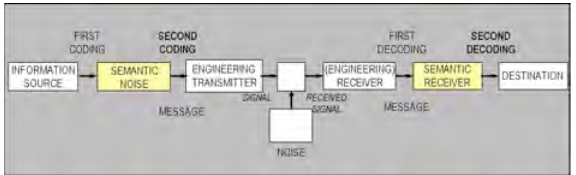
Fig. 4. Illustration of Weaver’s additional “boxes” in Shannon’s communication